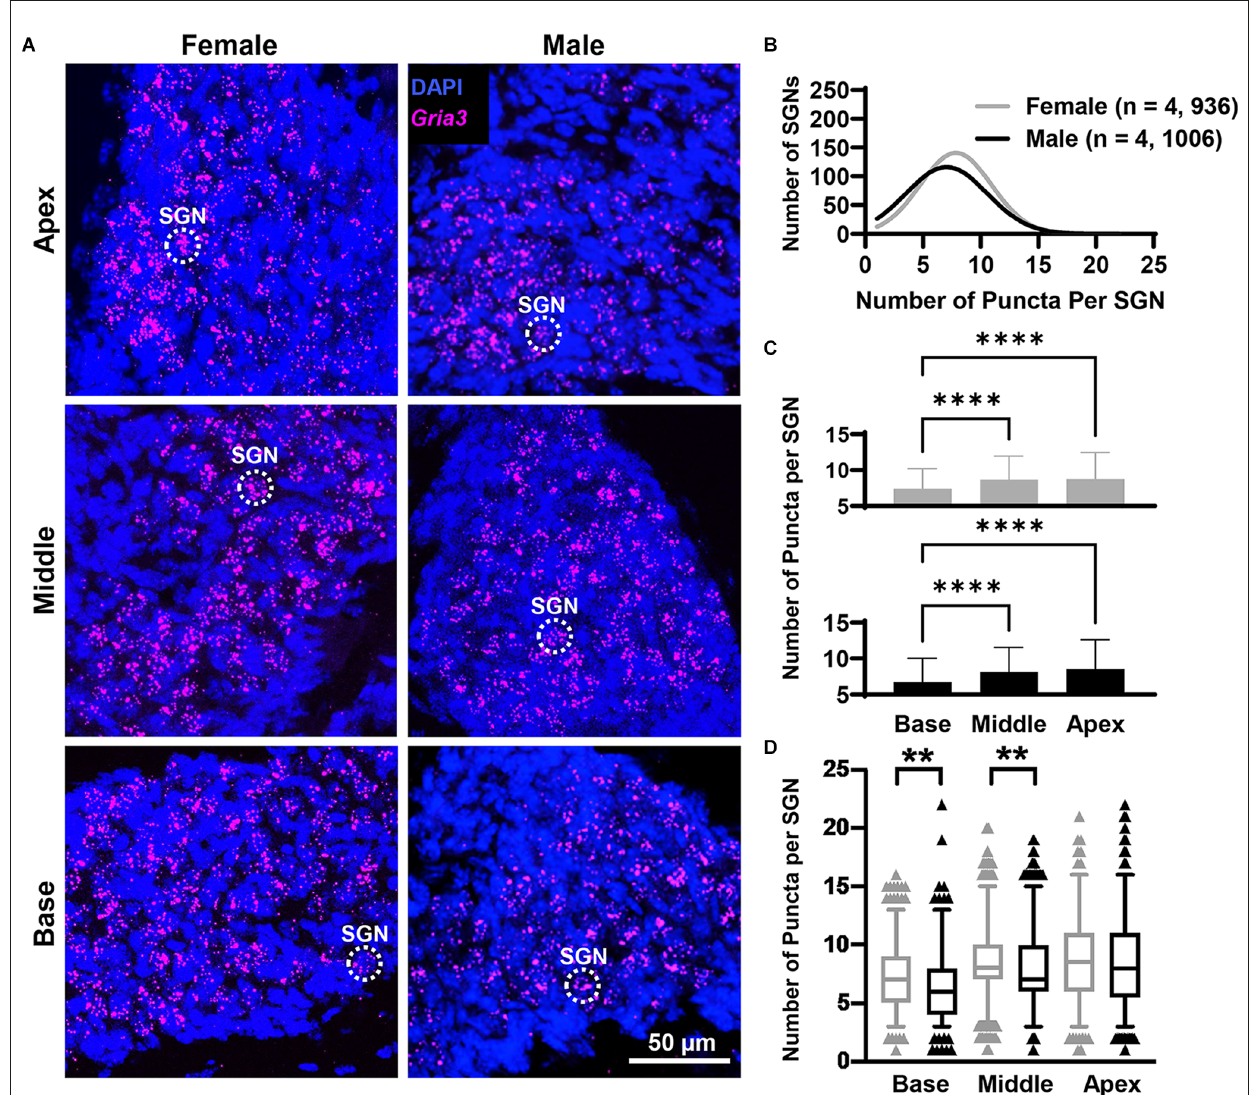
FIGURE4 Gria3 mRNA counts analyzed by cochlear region and sex. (A) Representative fluorescent confocal stack of images of Gria3 (false-colored in magenta) andDAPI(blue)inthebase,middle,andapexcochleaturnsforfemalesandmales. (B) Histogramrepresentingthedistributionof GriaA3 mRNAcounts in female (gray line) and male (black line) mice throughout the entire cochlea. Numbers in parentheses indicate the number of mice, followed by the total number of SGNs. (C) Bars show the mean Gria3 mRNA puncta on different cochlea turns on SGNs of female (gray bars, top) and male (black bars, bottom) mice. Error bars represent ± SD. (D) Whisker plots of GriaA3 mRNA puncta on different cochlea turns on SGNs of females (gray) and males (black). Females had more Gria3 mRNA in the basal and middle turns than males. Whiskers display the 5 and 95 percentiles. Samples consisted of the total number of SGNs for which Gria3 puncta were counted in females and males. See Table2 for sample sizes by region. Independent samples t-test, ** p < 0.01, ∗∗∗∗ p < 0.0001, see “Results” Section for specific p